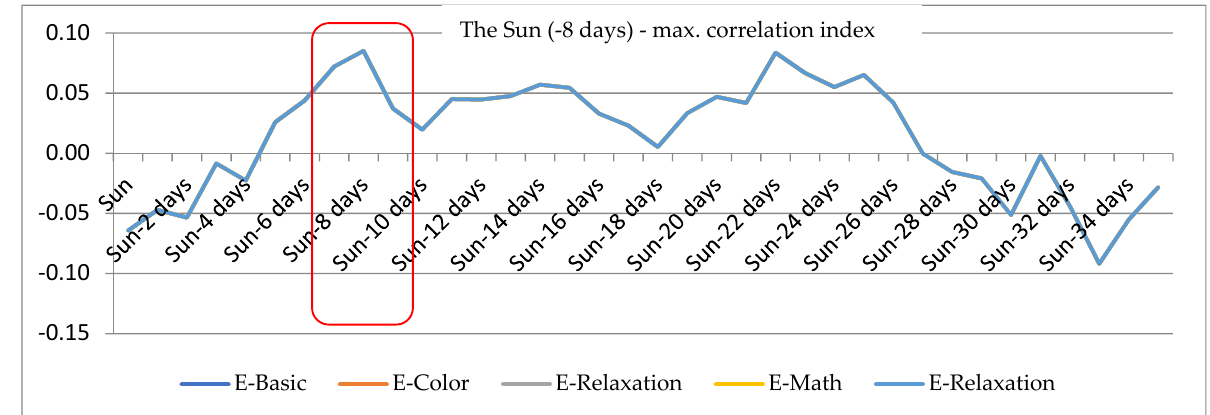
Figure 8. The correlation dependency of the psychophysiological parameter IFS on the intensity of solar activity.